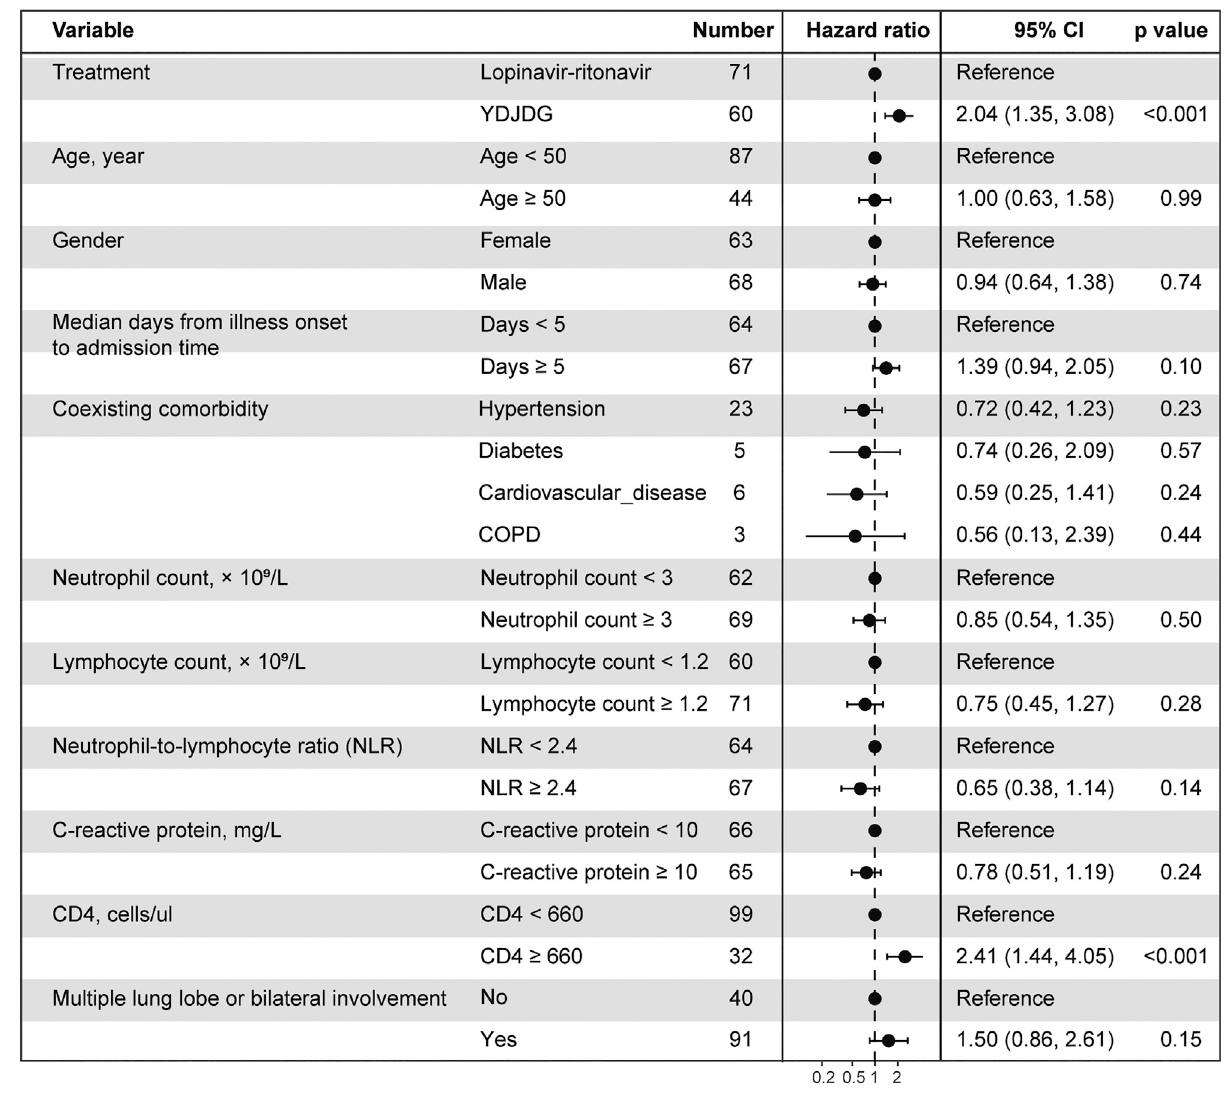
Frontiers in Pharmacology |